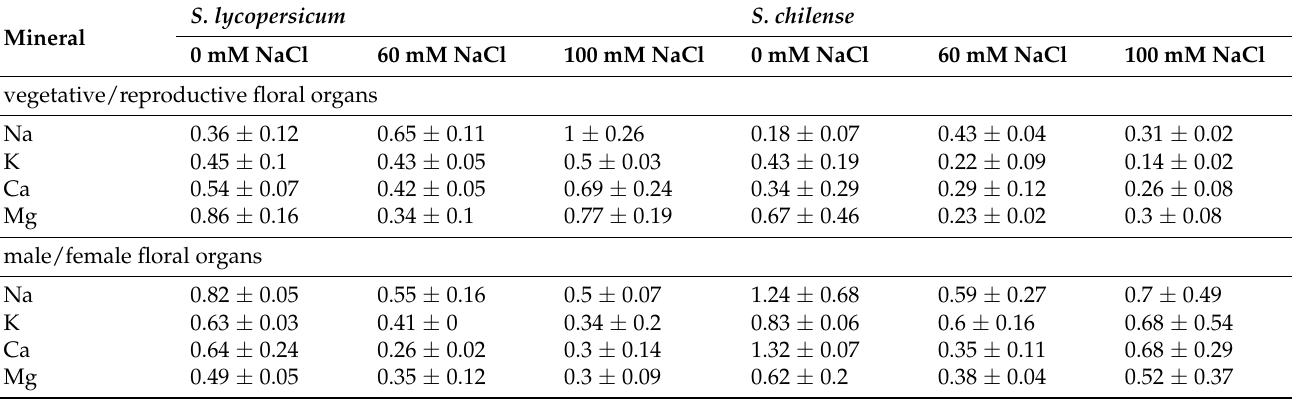
Table 4. Effects of salt stress on ratio (vegetative/reproductive organs and male/female organs) of mineral elements signals in flowers of Solanum lycopersicum and Solanum chilense grown at 0, 60, and 100 mM NaCl.